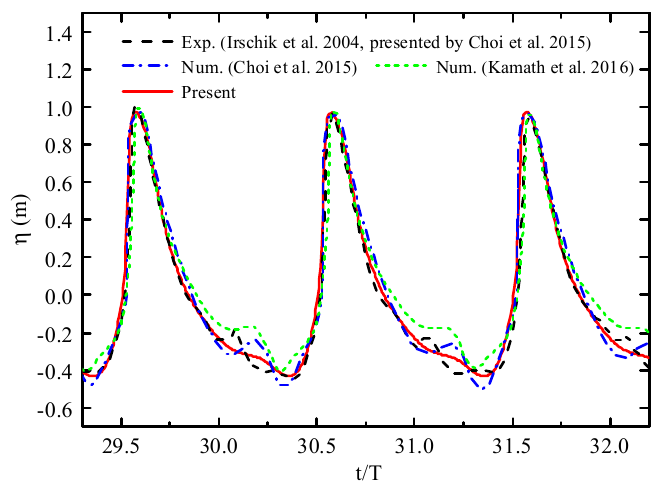
Figure 5. Comparison of free surface elevations at WG2 between the present result and the published data for the vertical cylinder.